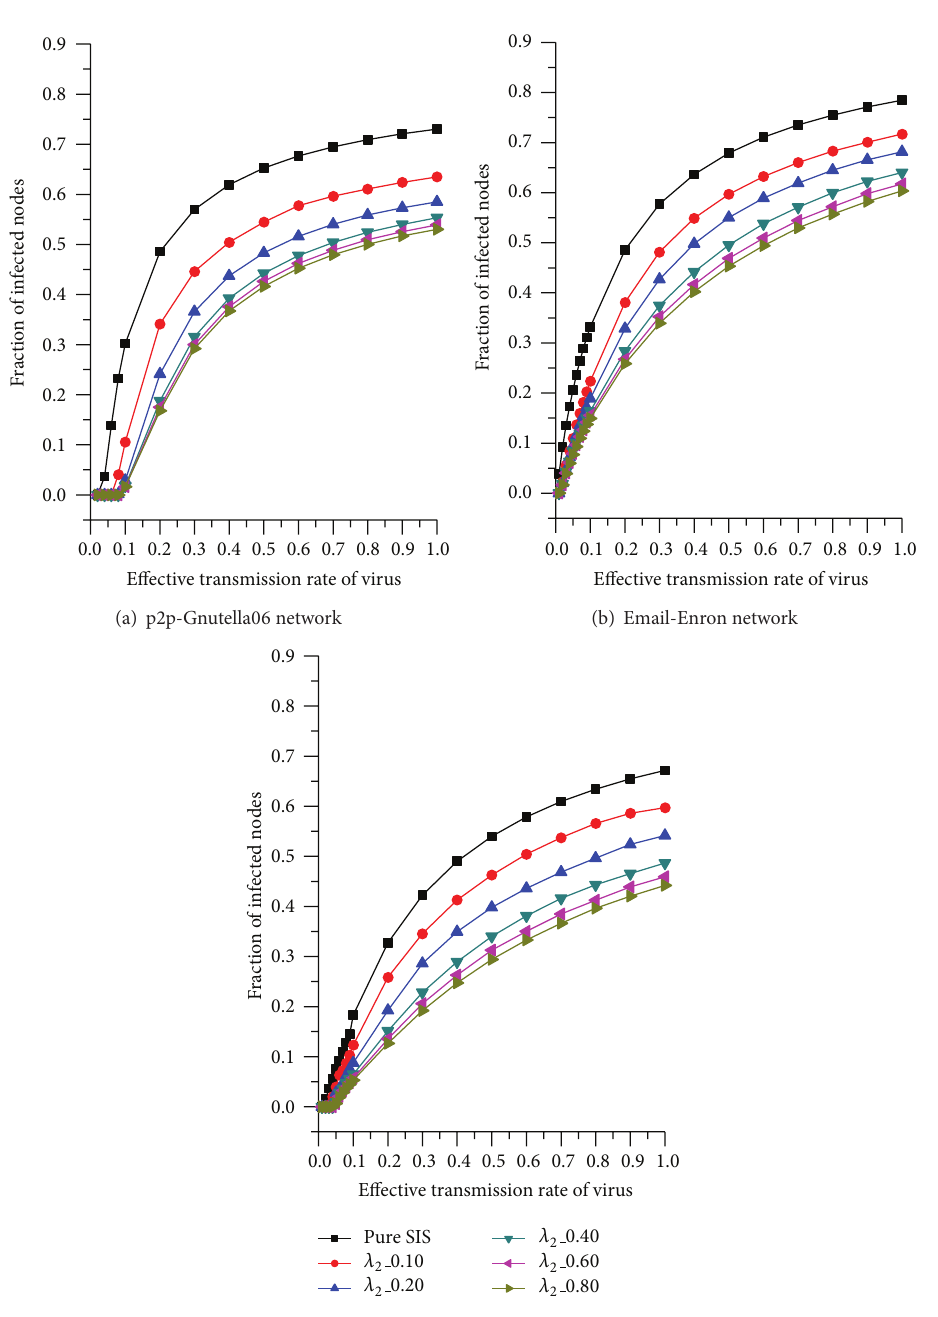
Figure 4: The node density 𝜌 (1) infected by virus as a function of virus effective transmission rate 𝜆 1 , for the different effective transmission rate 𝜆 2 of immune agent on different real-world networks, respectively. (a) p2p-Gnutella06 network, (b) Email-Enron network, and (c) AS network. The recovery rate of the virus spread 𝛽 (1) = 0.25 and the recovery rate of the immune agent spread 𝛽 (2) = 0.5 .